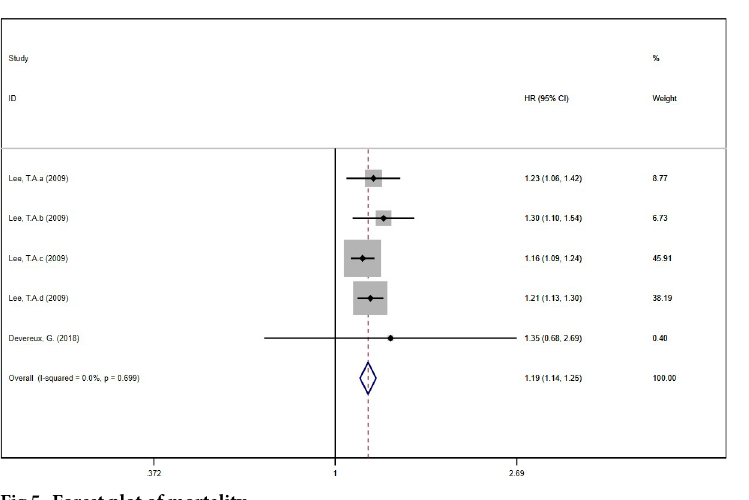
Fig 5. Forest plot of